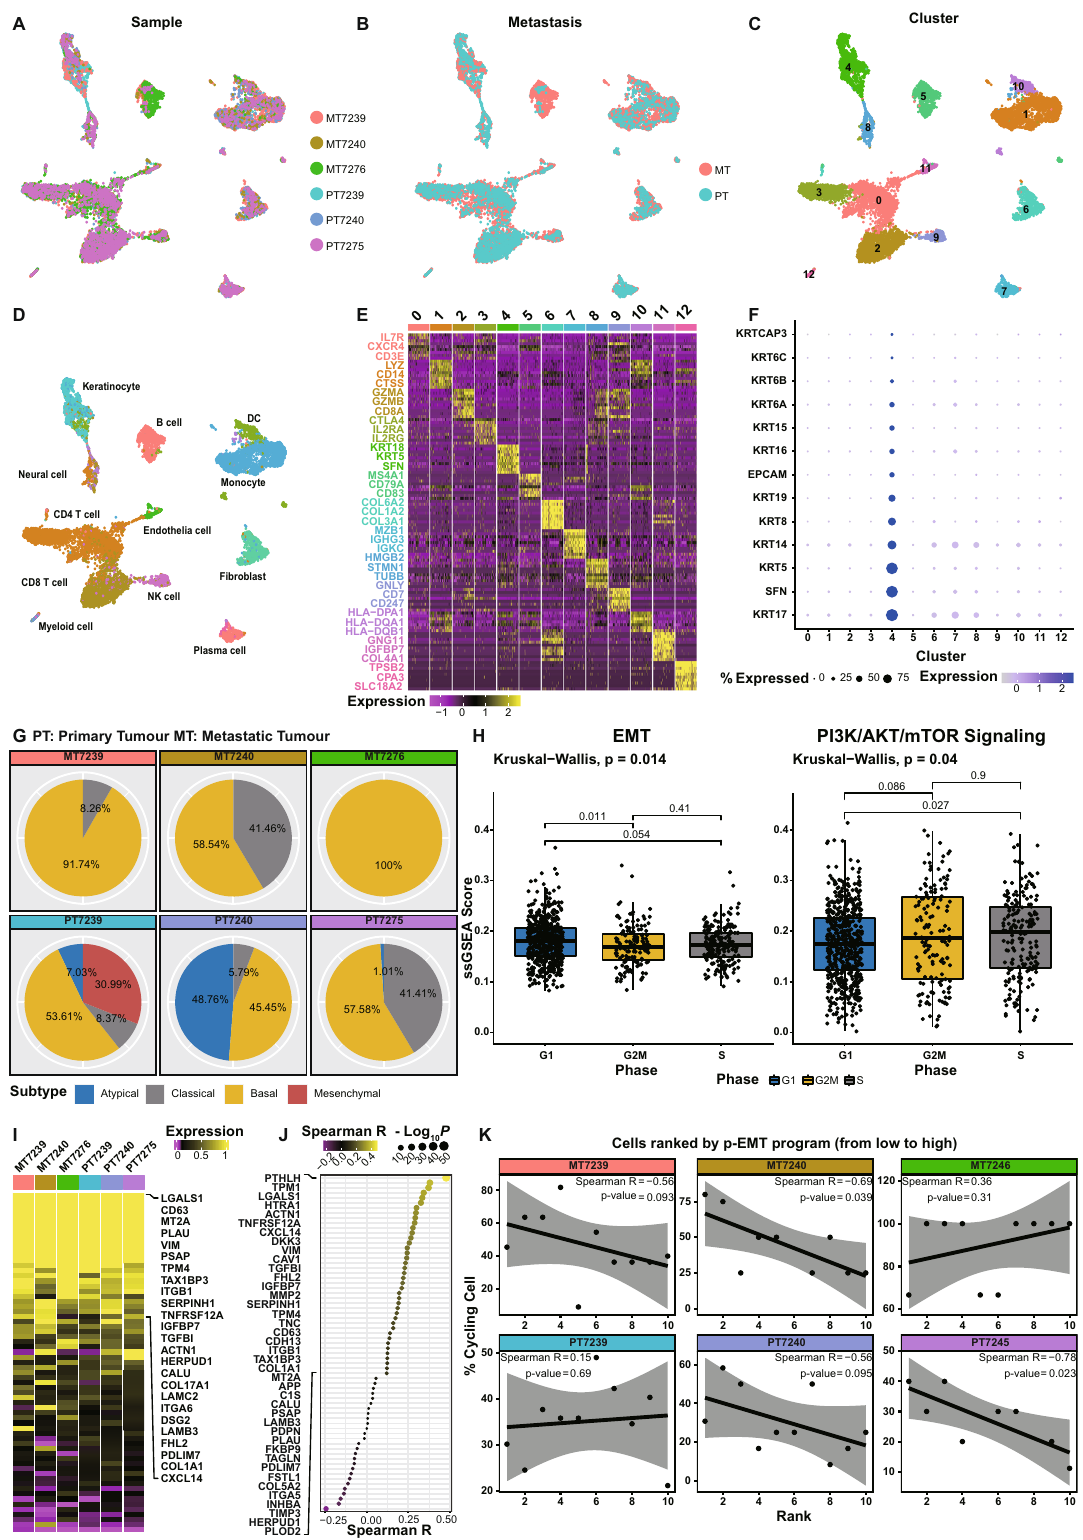
Six HNC cell lines were classi fi ed into molecular subtypes using